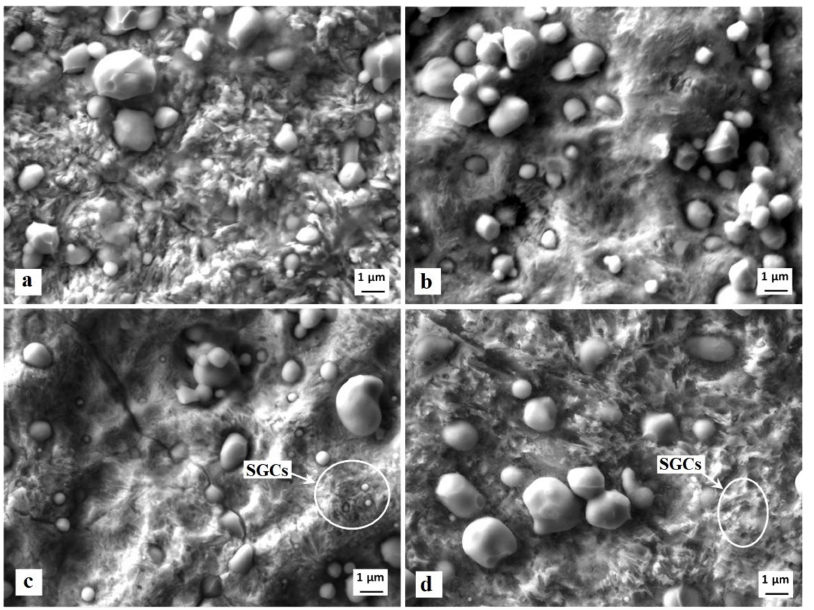
Figure 12. SEM micrographs showing the surfaces after the potentiodynamic polarisation measurements, CHT ( a ), CHT + tempering at 530 ◦ C ( b ), SZT at − 140 ◦ C ( c ), SZT at − 140 ◦ C + tempering at 530 ◦ C ( d